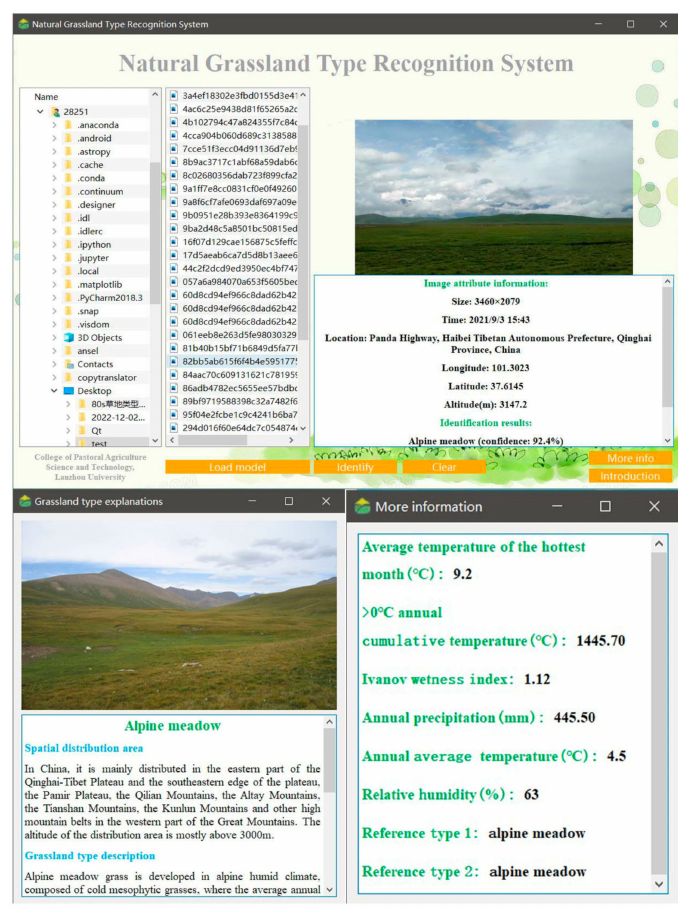
Figure 9. The user interface for the grassland-type recognition system. Reference type 1 is the reference grassland type obtained based on the grassland resource-type map, and reference type 2 is the reference grassland type obtained based on the classification of meteorological